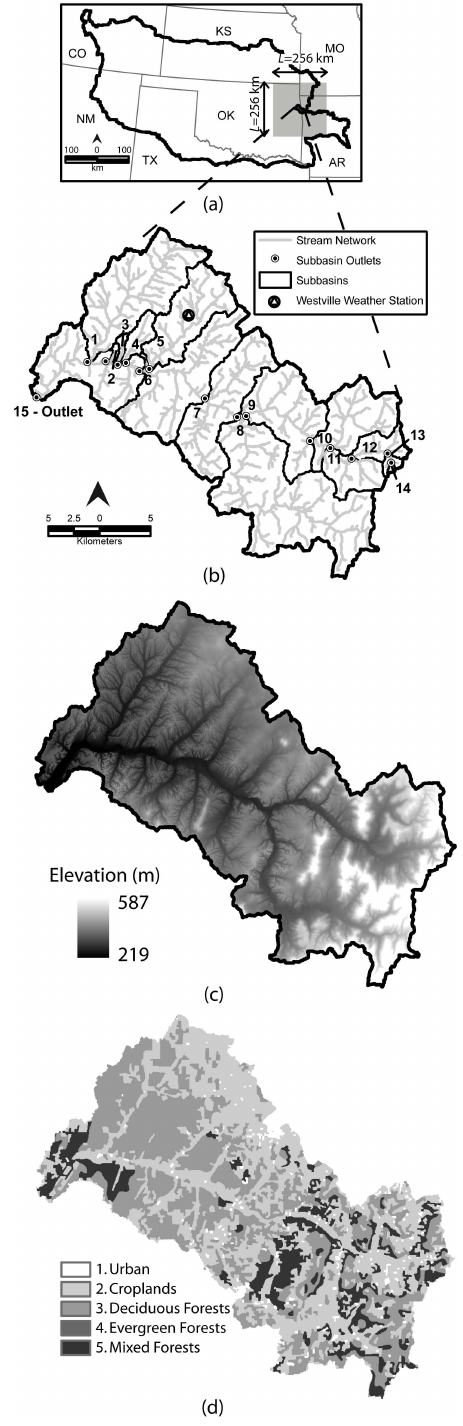
Fig. 1. (a) Baron Fork basin location within the Arkansas Red River basin. The coarse-scale domain L × L used for rainfall downscaling is plotted with a gray square. (b) Baron Fork basin boundaries, channel network, boundaries and outlets of the 15sub-basins (Ta- ble 1), and the Westville meteorological station. (c) US Geological Survey (USGS) Digital Elevation Model (30-m); (d) Land Cover map derived from the USGS Land Use and Land Cover (LULC)